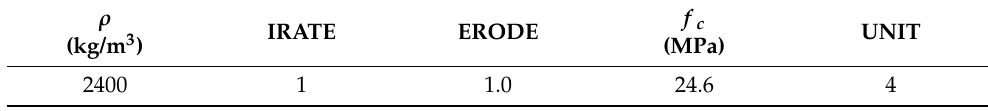
Table 2. Parameters of the concrete